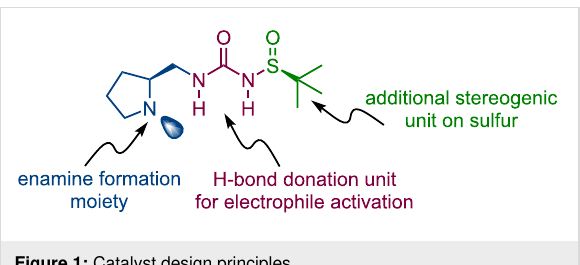
Figure 1: Catalyst design